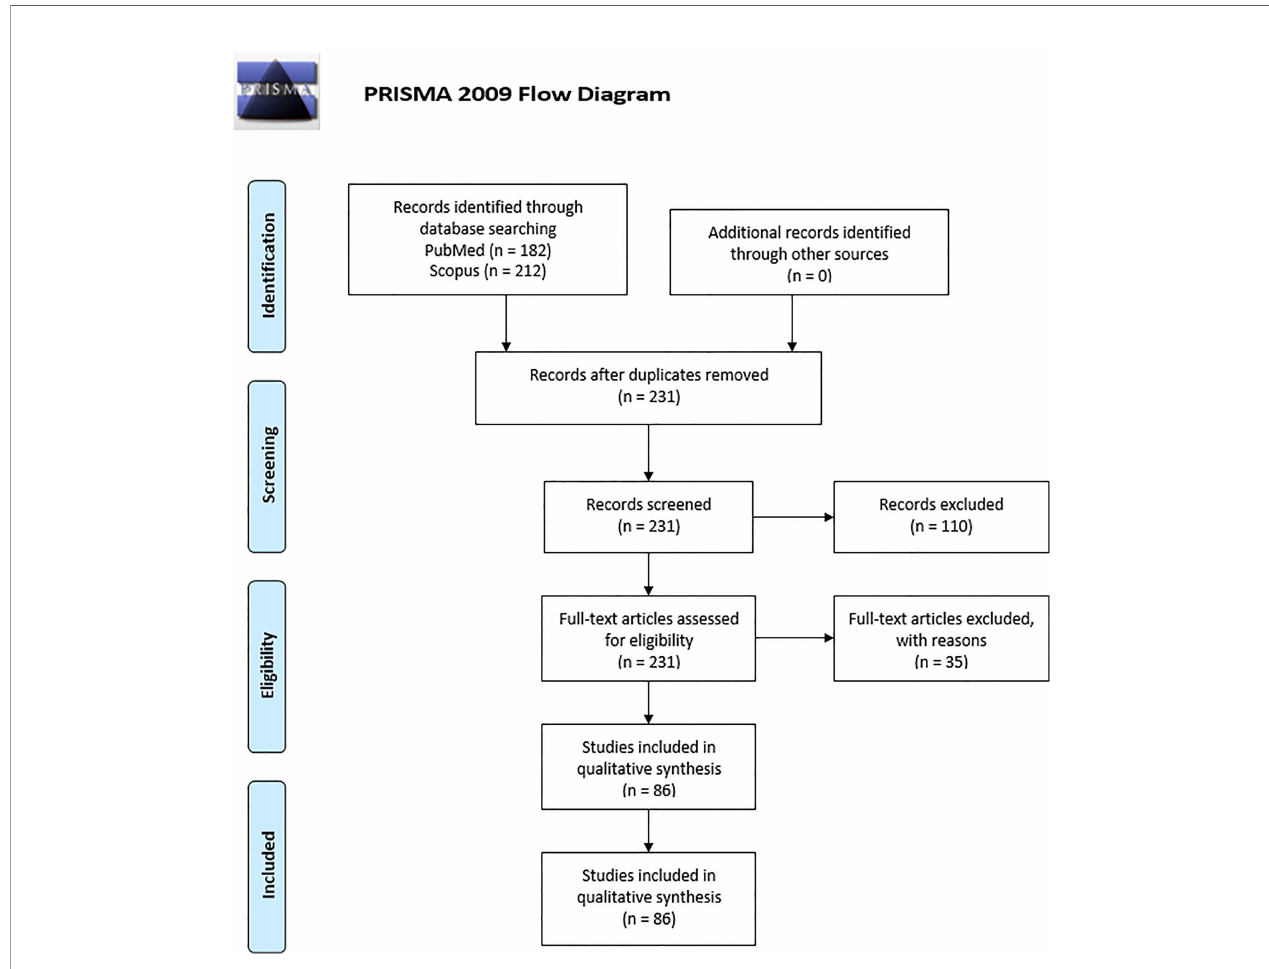
FIGURE 1 | PRISMA 2009 fl ow diagram of literature search and records